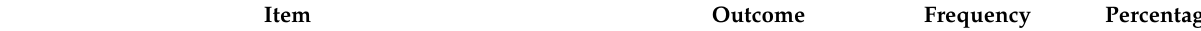
Table 3. Responses of the participating Palestinian students to the COVID-19-related knowledge subscale, May 2020 ( n = 951). Item Outcome Frequency